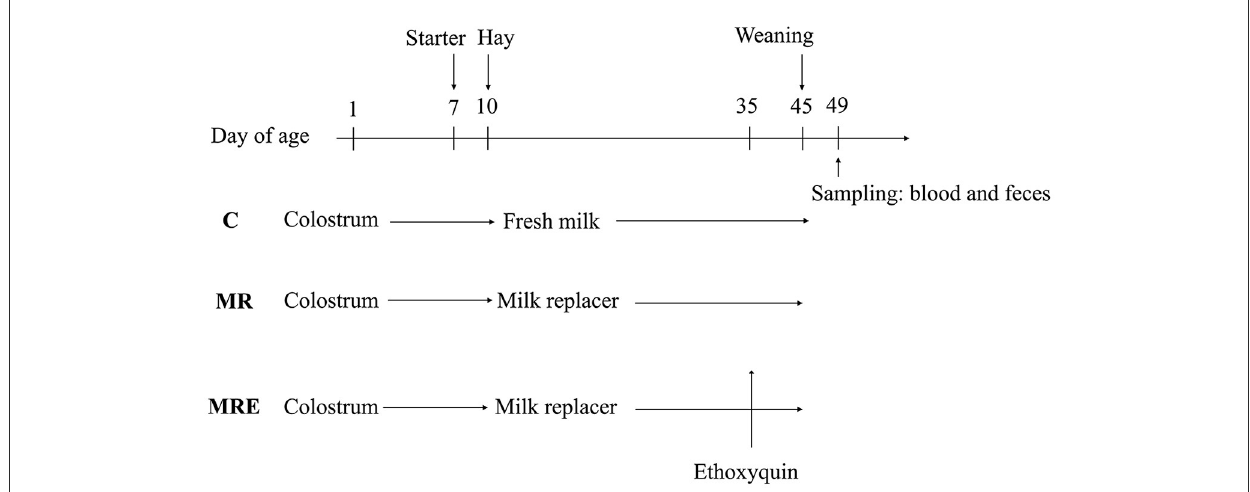
FIGURE1 Overall timeline of the experimental protocol showing the change of treatments, starter, weaning and sample collection. C, calves fed fresh milk; MR, calves fed milk replacer; MRE, calves fed milk replacer plus ethoxyquin at 350 mg/kg group.